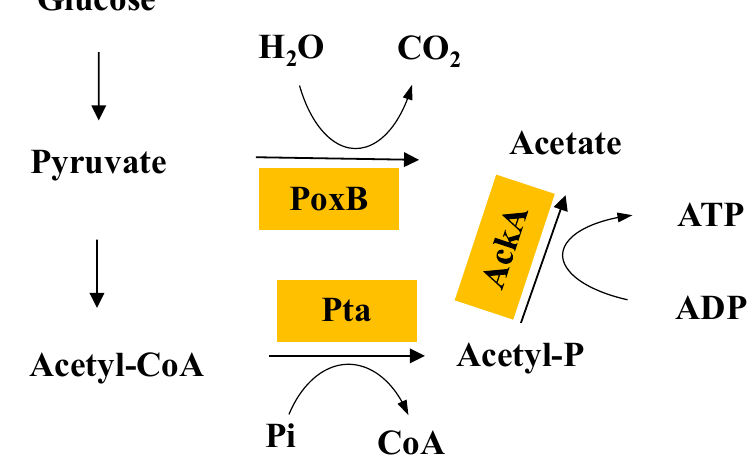
Figure 3. The acetate biosynthesis pathway in E. coli .